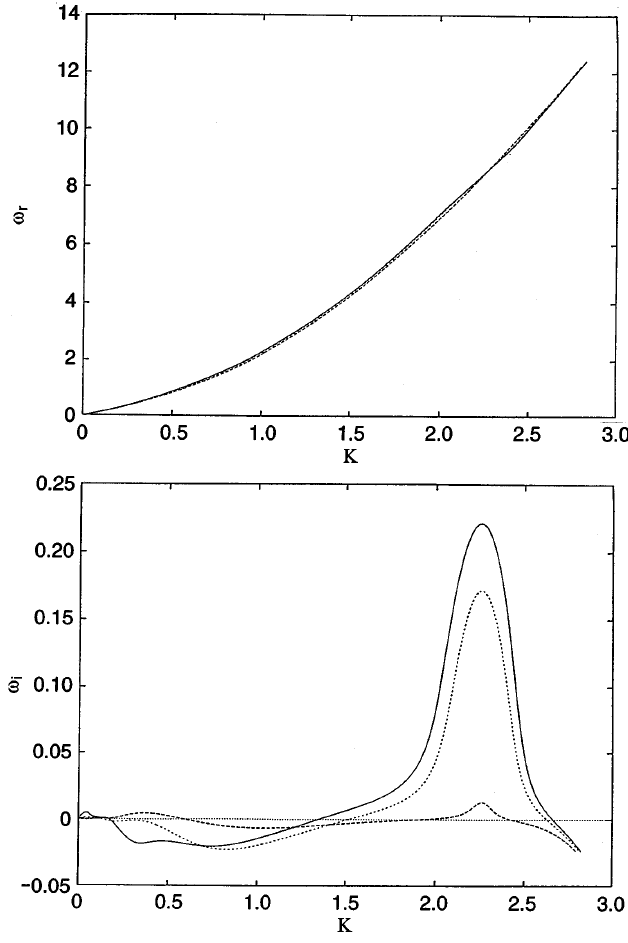
Fig. 3. Real and imaginary parallel dispersion of the reference magnetoplasma (unstable modes) for three situations where the gyrophase bunchings are monochromatic: ( solid line ) nongyrotropic protons and alpha particles, as in Fig. 2; ( long dashed line ) gyrotropic protons and nongyrotropic alpha particles, ( short dashed line ) gyrotropic alpha particles and nongyrotropic protons. Normaliza- tions as in Fig. 1